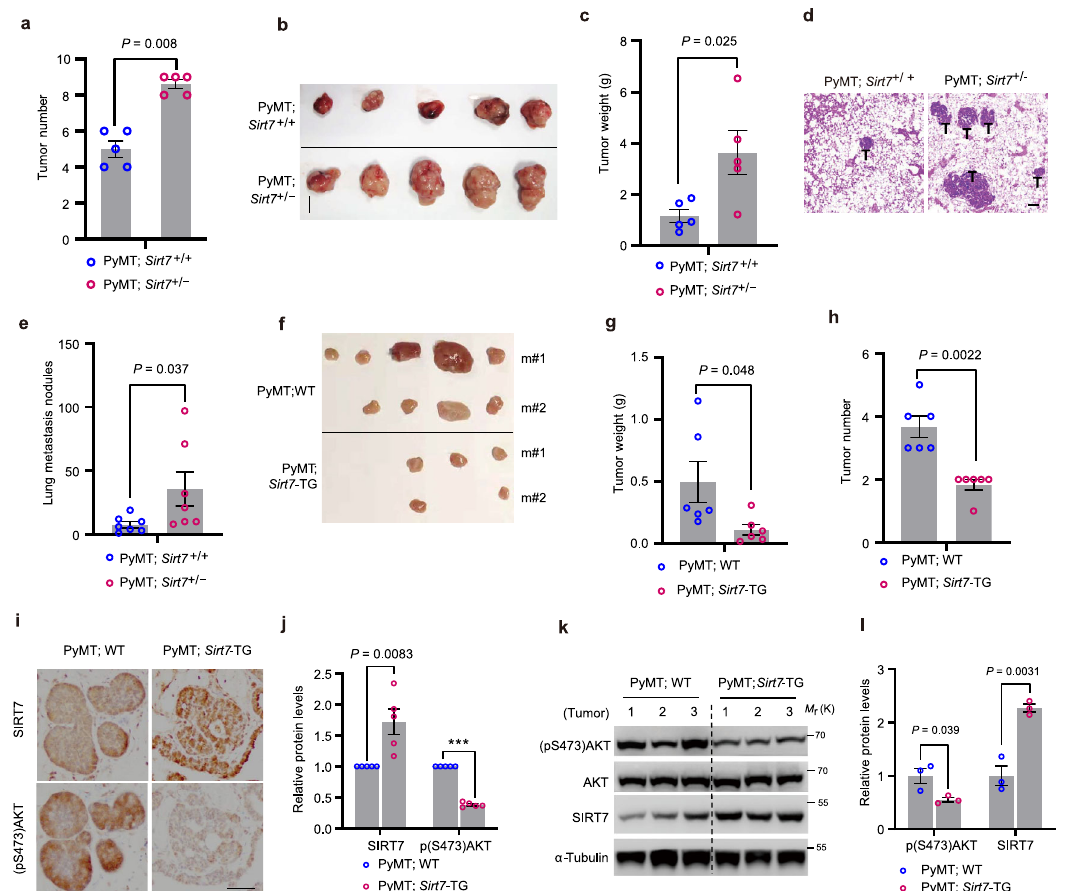
Fig. 6 SIRT7 suppresses tumor progression. a , b Total tumor number ( a ), largest tumor ( b ), and whole tumor weight ( c ) were analyzed in PyMT; Sirt7 + / + and PyMT; Sirt7 + / − mice aged 4 months ( n = 5 mice per group); scale bar, 1 cm. d Representative images of H&E staining showing lung metastatic nodules (labeled as T) in PyMT; Sirt7 + / + and PyMT; Sirt7 + / − mice, analyzed from n = 5 mice per group; scale bar, 500 µ m. e The number of lung metastatic nodules was counted in H&E-stained whole-lung sections ( n = 7 mice per group). f – h Tumor burden ( f , g ) and number ( h ) in PyMT;WT and PyMT; Sirt7 -TG